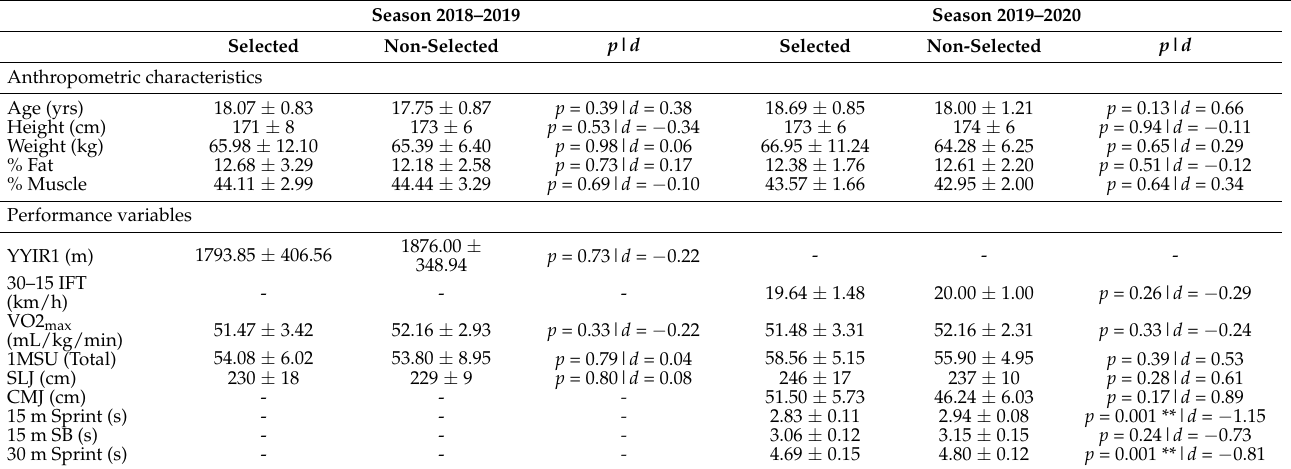
Table 2. Anthropometric characteristics and performance variables (mean ±